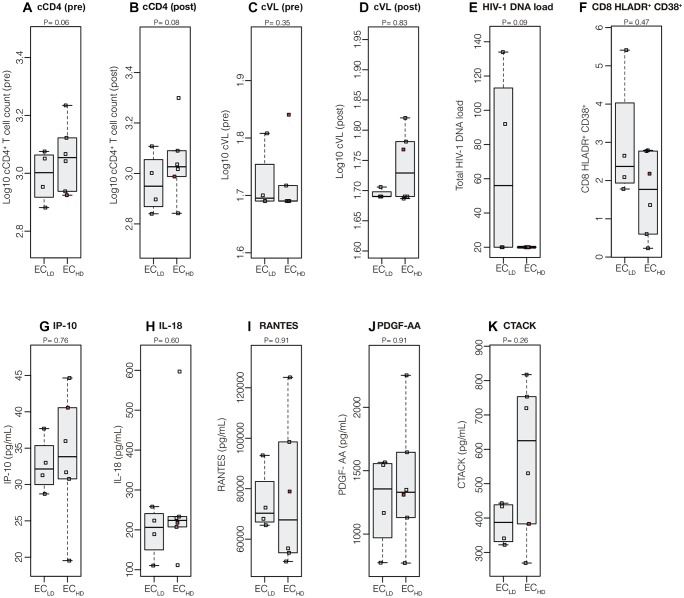
Virologic and immunologic progression markers in ECLD and ECHD subgroups. Mean (log10-transformed) cumulative measures of CD4+ T cell counts (A,B) and VL (C,D) in the pre- and post-periods respect to the point of determination of env proviral diversity and the total cell-associated HIV-1 DNA load (E), frequency of activated CD8+ T cells (F), and plasmatic levels of IP-10 (G), IL-18 (H), RANTES (I), PDGF-AA (J), and CTACK (K) at the env proviral diversity point were compared between EC subgroups. Central black solid bars and boxplots represent sample medians and interquartile, respectively. The red point in each graph indicate the values obtained for the subject who had putative virologic progression (EC42HD). P-values were obtained with Wilcoxon signed-rank tests.